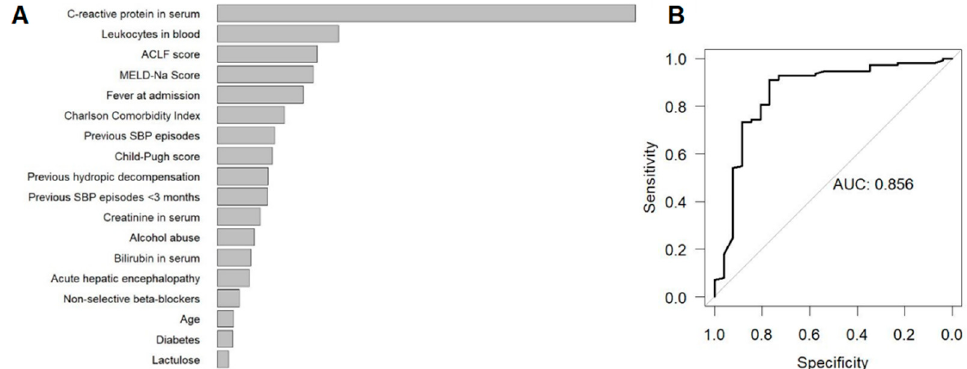
Figure 1. Results of the Random Forest model to identify the most important features to differentiate SBP or SecP from uninfected ascites prior to diagnostic paracentesis. ( A ) Internally validated (out- of-bag) variable importance of most important features. ( B ) Internally validated (out-of-bag) ROC and AUC of the Random Forest model. Abbreviations: ROC, receiver operating characteristics curve; AUC area under the ROC.